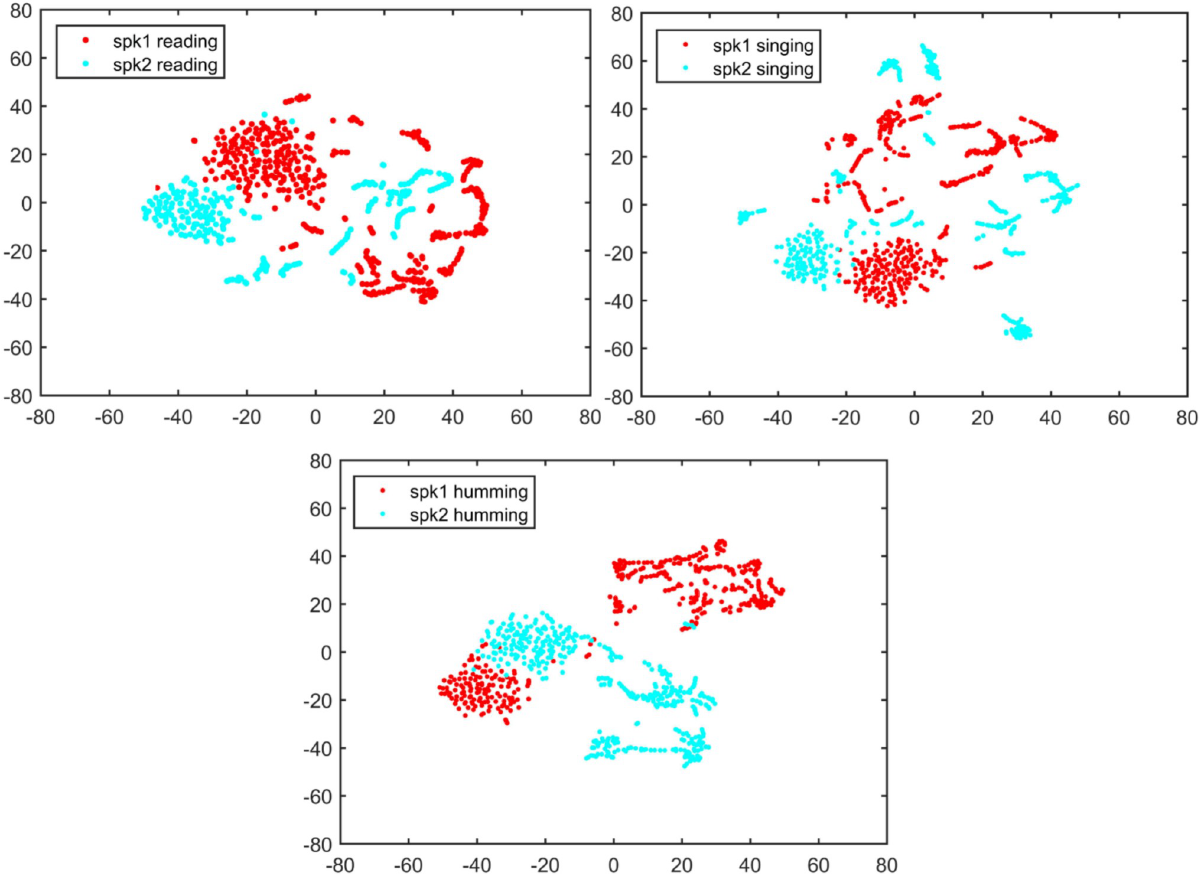
Fig 4. Two speaker’s feature space discrimination using t-SNE for each speaking style under text-independent condition. The texts are the same for each speaker with three speaking styles.